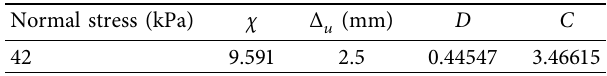
Table 4: Model parameter values obtained by interpolation using different interval regions.